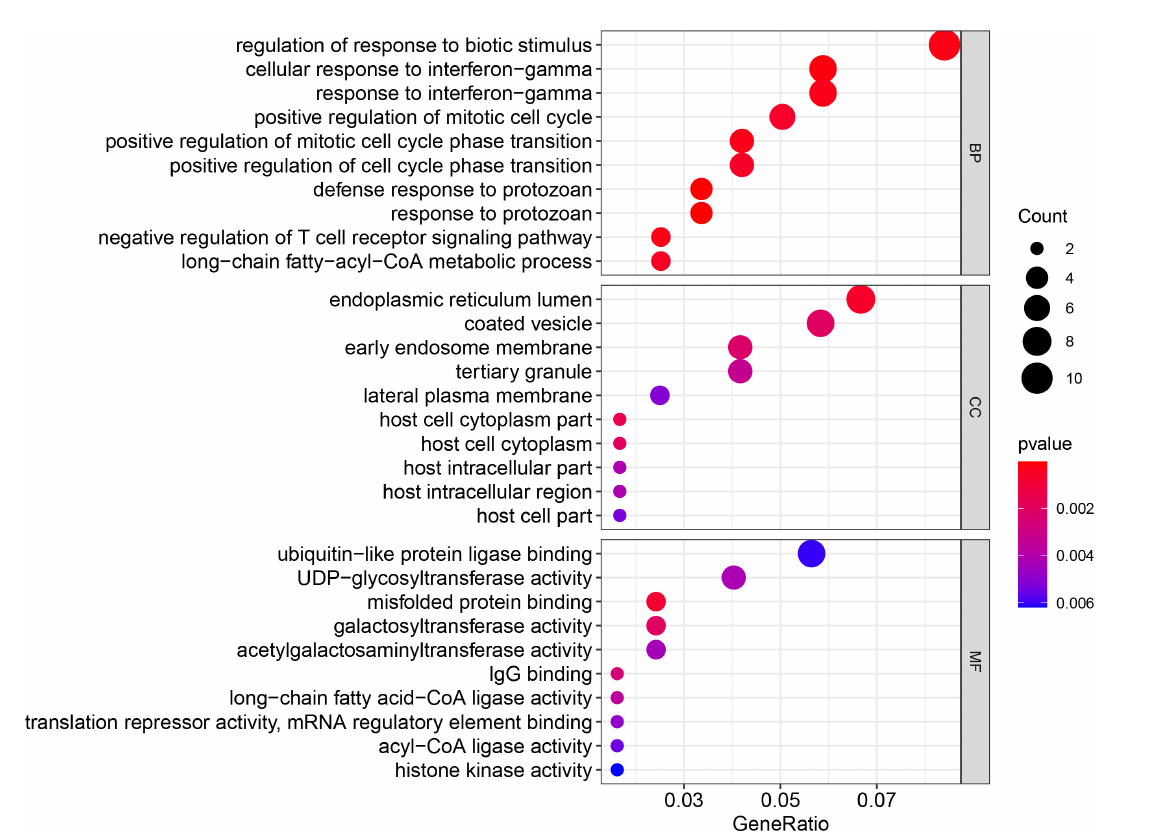
FIGURE8 Gene Ontology enrichment of 149 MEgreenyellow genes. The count shows the number of genes enriched in the pathway. Gene ratio: the ratio of the gene number in this term to the total number of the MEgreenyellow